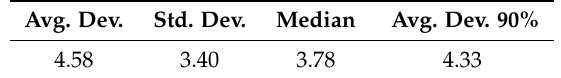
Table 2. Average deviation (as %) of the prediction of the yield